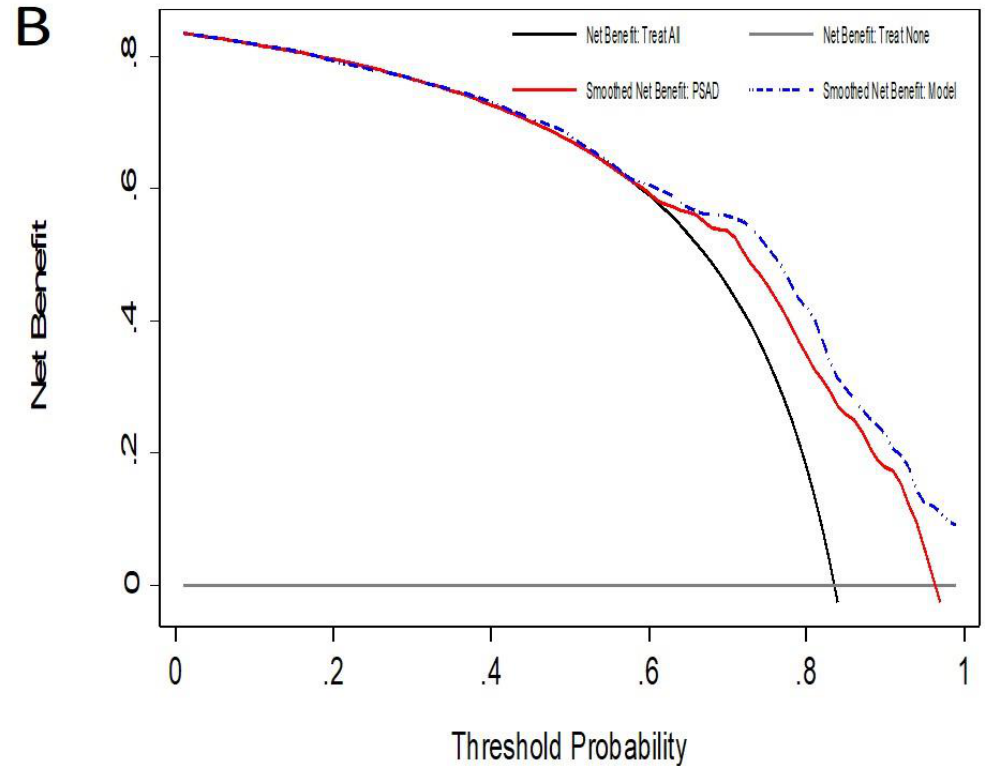
Figure 5. The ROC curves and AUCs show the efficacy of mPSAD (PSAD in the graphic) and MRI- PMbdex (model in the graphic) in detecting csPCa in men with PI-RADS 5 ( A ). The DCAs showing the net benefit of mPSAD and MRI-PMbdex over performing biopsies on all men according to the csPCa probability threshold ( B ). The selected thresholds for MRI-PMbdex and mPSAD provided sensitivities of 100% and 97.3% as well as specificities of 4.6% and 20%, respectively, in men with PI-RADS 5. MRI-PMbdex avoided 0.8% of prostate biopsies, while mPSAD avoided 5.6%. The rate of missed csPCa was 0% for MRI-PMbdex and 2.7% for mPSAD. Moreover, mPSAD did not detect 4 PCa with ISUP-GG ≥ 4 (Table 7). Table 7. Performance of MRI-PSAD and Barcelona MRI-predictive model in men with PI-RADS 5, from the respective thresholds of 0.628 ng/mL 2 and 13.5%.